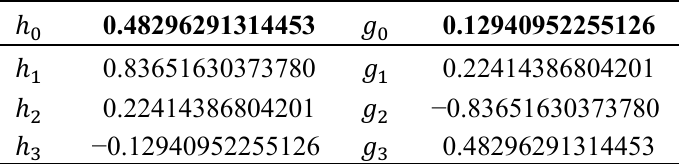
Table 1. The coefficients of the “db4” filter.